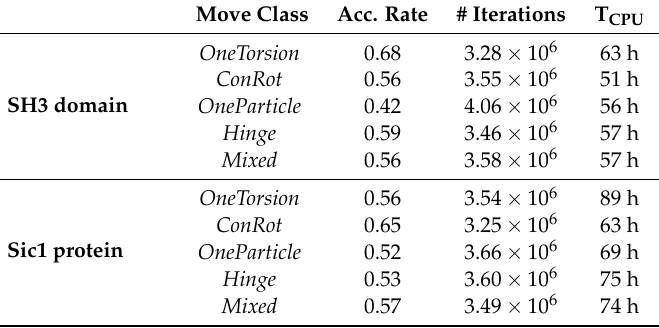
Table 2. Computational performance.